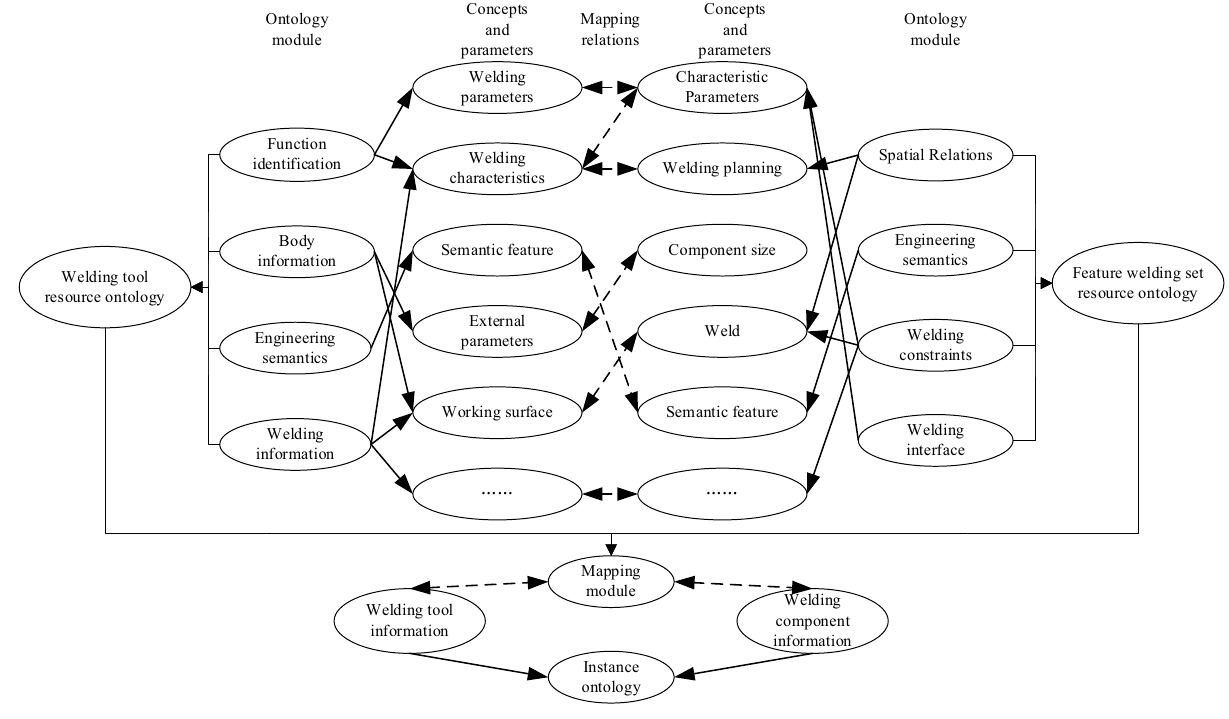
Figure 6. Mapping relationship between ontology.